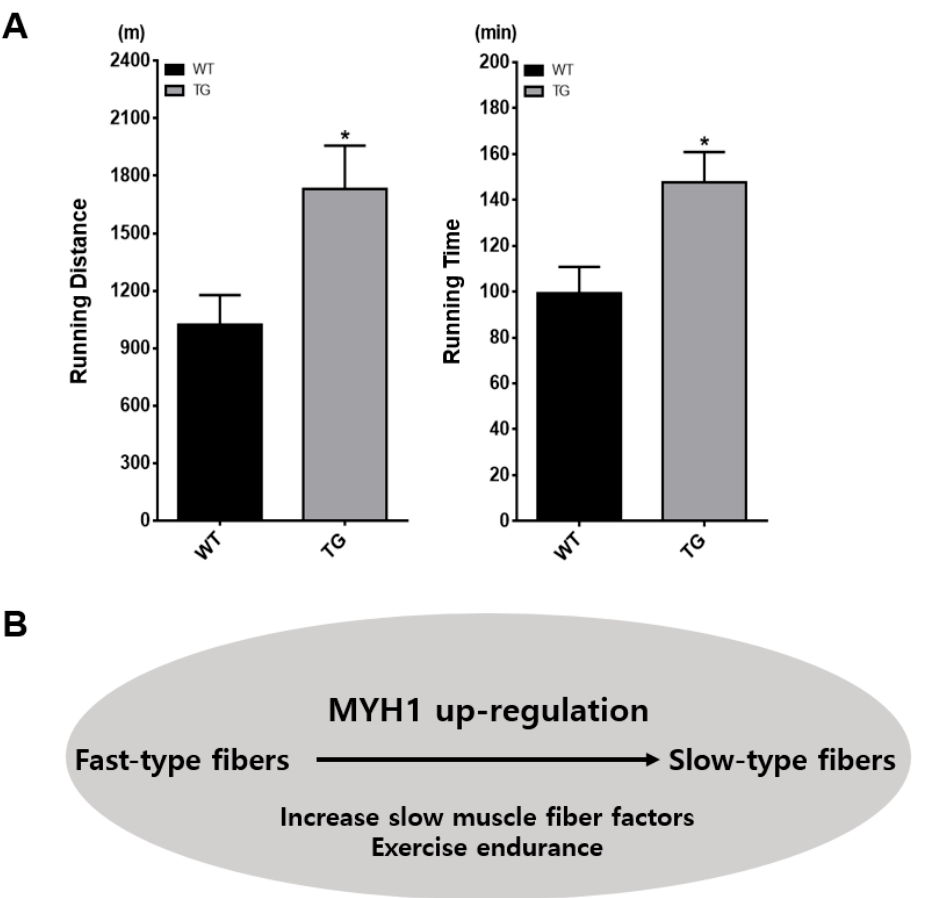
Figure 6. Enhanced physical exercise with Myh1. ( A ) Exercise endurance test in WT and TG mice on a treadmill. Sixteen-week-old male mice were subjected to a treadmill with foot-shock ( n = 3 for each group). Running time and distance were checked until mice were exhausted. Data are expressed as the mean ± SEM for three mice in each group and multiple t -tests were used for the statistical analysis. * = p < 0.05. ( B ) Diagram of Myh1 function in skeletal muscle.